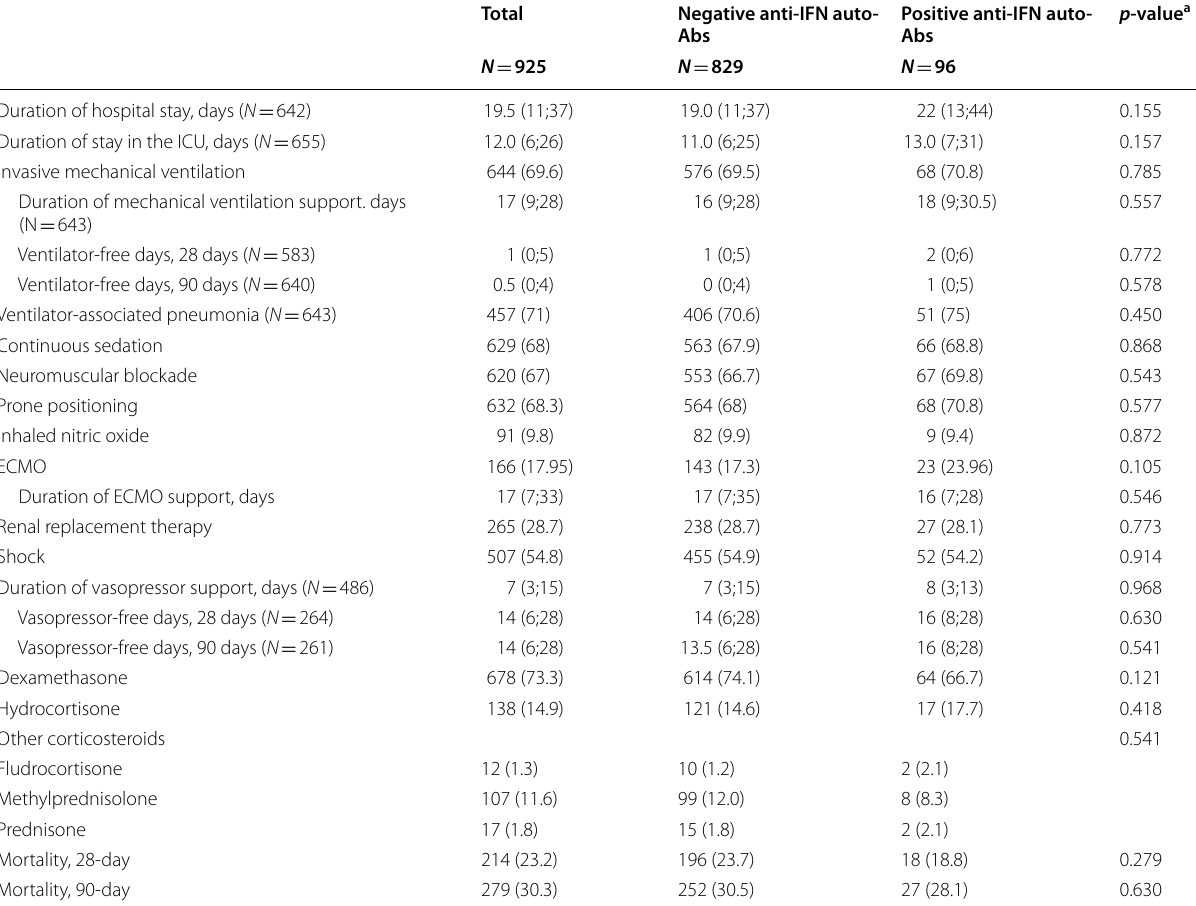
Continuous values are shown as median (quartile 1-quartile 3); qualitative values are shown as number (percentage); a P values come from Fisher’s or Chi 2 tests, and Student’s t tests or Mann–Whitney tests, as